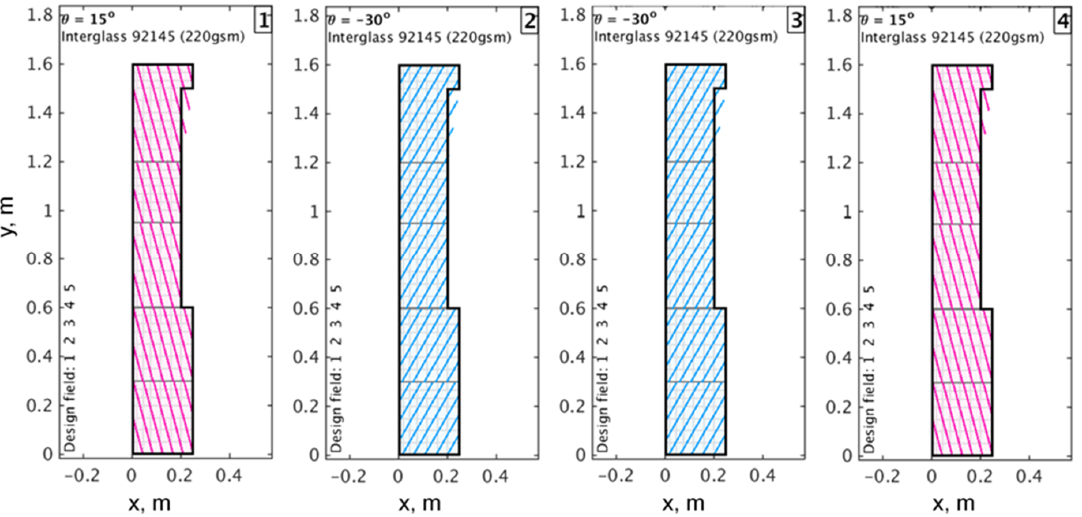
Figure 10. Stacking sequence for the η max objective model.